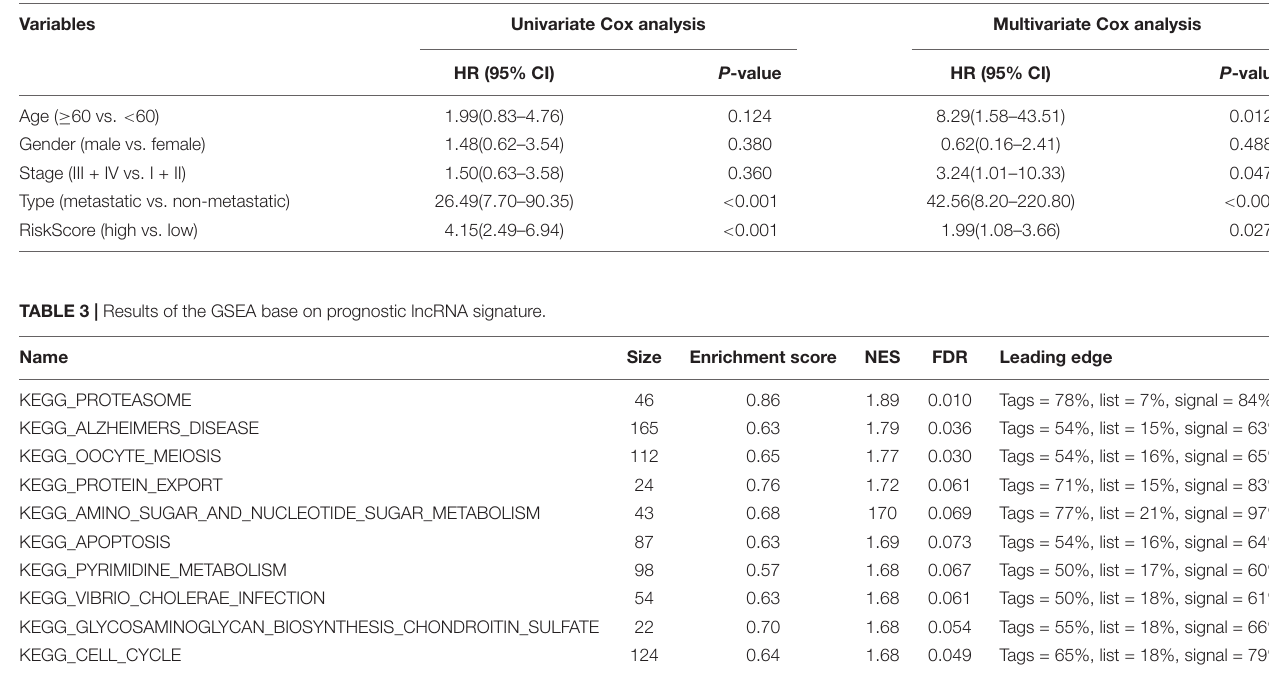
TABLE 2 | Univariate and multivariate Cox analysis of prognostic lncRNA signature and clinical features for OS in TCGA cohort.